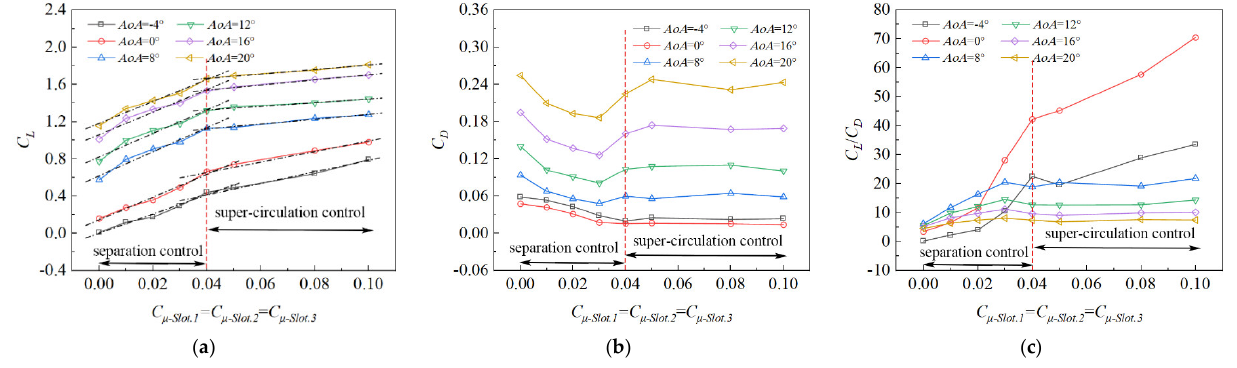
Figure 8. Wing aerodynamic characteristic curve with increasing blowing coefficient ( U ∞ = 8 m/s). ( a ) Lift coefficient. ( b ) Drag coefficient. ( c ) Lift-to-drag ratio.